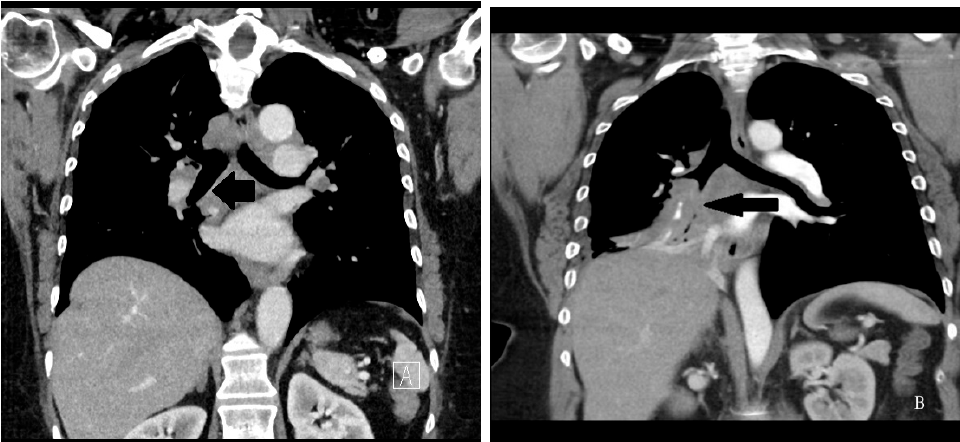
Figure 7. ( A ) Left figure: Chest CT sagittal image of mediastinal lymph nodes from sarcoidosis. The lymph nodes do not appreciably disturb airway patency, and the right bronchus intermedius is completely unobstructed (arrow); ( B ) Right figure: Chest CT sagittal image of mediastinal lymph nodes from small cell lung carcinoma. The lymph nodes do not respect anatomic boundaries and compromise the right bronchus intermedius (arrow).